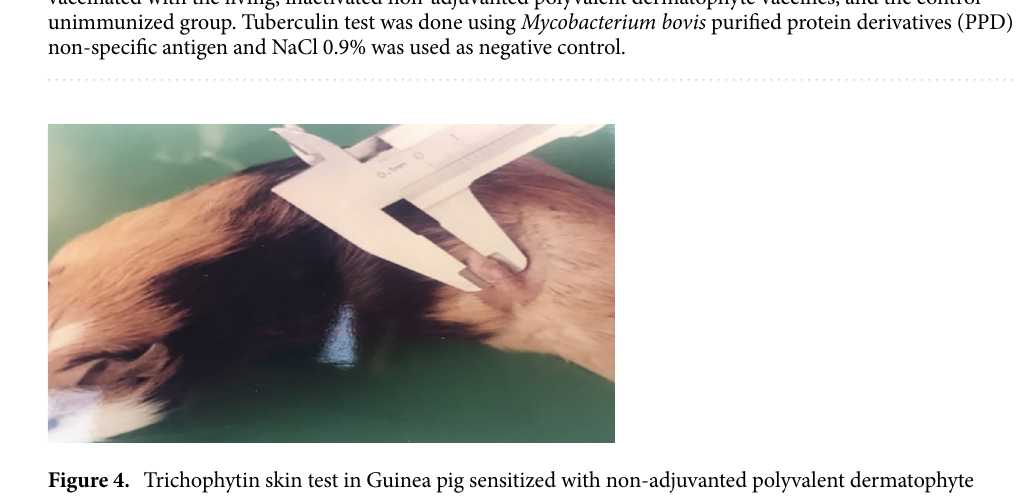
Figure 4. Trichophytin skin test in Guinea pig sensitized with non-adjuvanted polyvalent dermatophyte vaccine, typical delayed hypersensitivity skin reaction is illustrated.